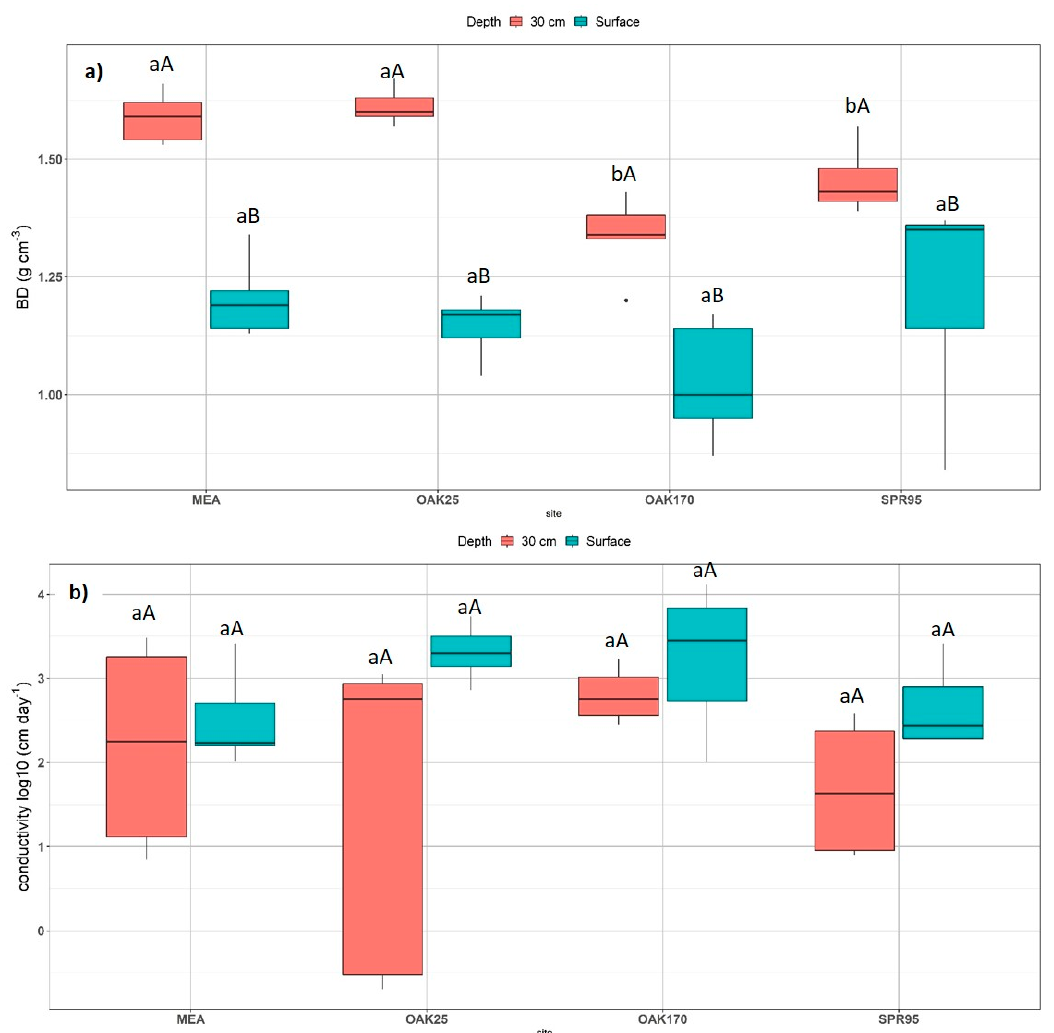
Figure 3. Bulk density ( a ) and saturated hydraulic conductivity (log10) measured in the laboratory and ( b ) derived from the 250 cm 3 cores for the four sites for surface and 30 cm depth, respectively; sample size n = 5 for all sites and depths. Same lowercase letters indicate no significant differences among sites ( p < 0.05). Same uppercase letters in a column indicate no significant differences within the sites among depth ( p <